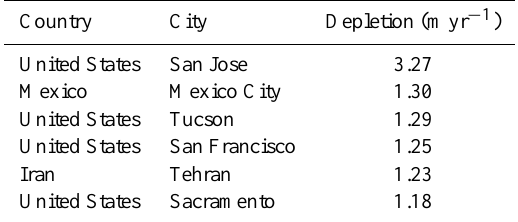
Table 1. Calculated depletion (myr − 1 for the period 2000–2010) for a selection of cities that are known to